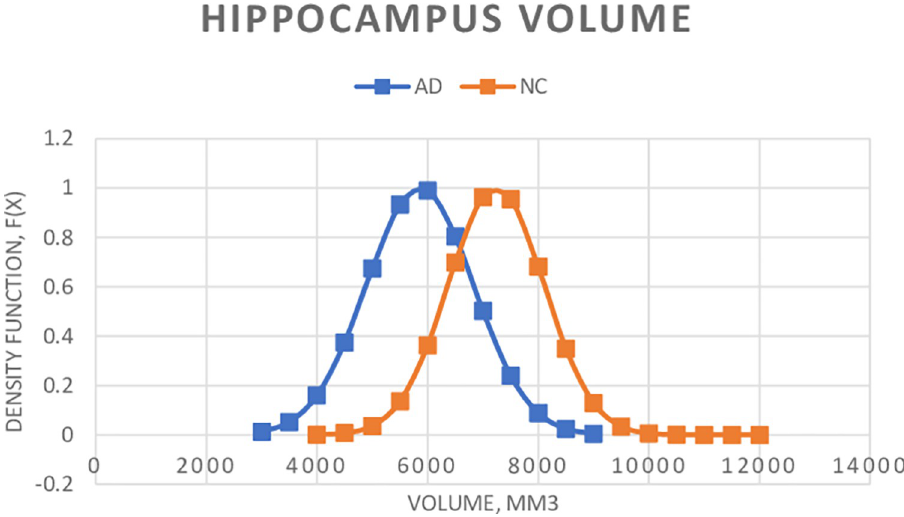
Fig 3. Probability density distributions of total volumes of the hippocampus: Normal controls (NC) vs Alzheimer’s disease (AD). The total mean volumes ( ± SD) of the hippocampus are 5962.2 ( ± 1025.3) and 7238.4 ( ± 870.0) mm 3 for AD and NC